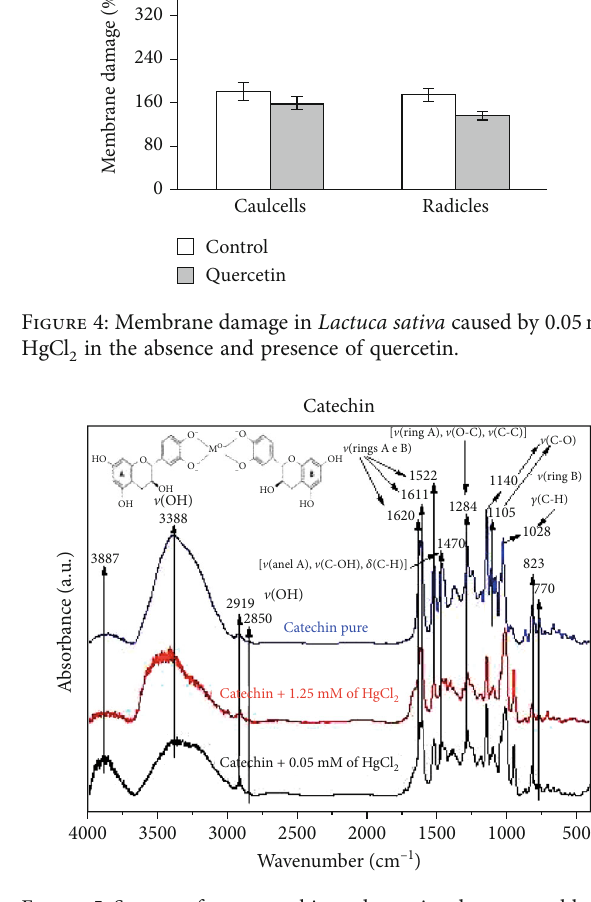
Figure 2: E ff ect of isolated mercury chloride (HgCl association with quercetin on the dry mass of radicles and stems of Lactuca sativa .